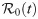
Model fitting results under two scenarios: Scenario 1 (weak infectivity with ψ = 0.1) in panels (a,b) and scenario 2 (strong infectivity with ψ = 0.5) in panels (c,d).Black line with circles denote reported cases (in (a), in the form of square-root) and reported deaths (in (b), in the form of square-root), and red line denotes model simulation median. Blue dashed line denotes the fitted basic reproduction number, R0(t), and the green dashed line shows the calculated host susceptible proportion, S(t) (or Sh(t)/Nh in the model Eq 1). Shaded region represents 95% bound of 1,000 model simulations. Vertical dashed line indicates the start date of the vaccination campaign. Inset panel shows BIC as a function of the number of nodes (nm). The lowest BIC is attained at nm = 7 in both scenarios, which is used in the main panel. Parameter values are listed in Table 2.